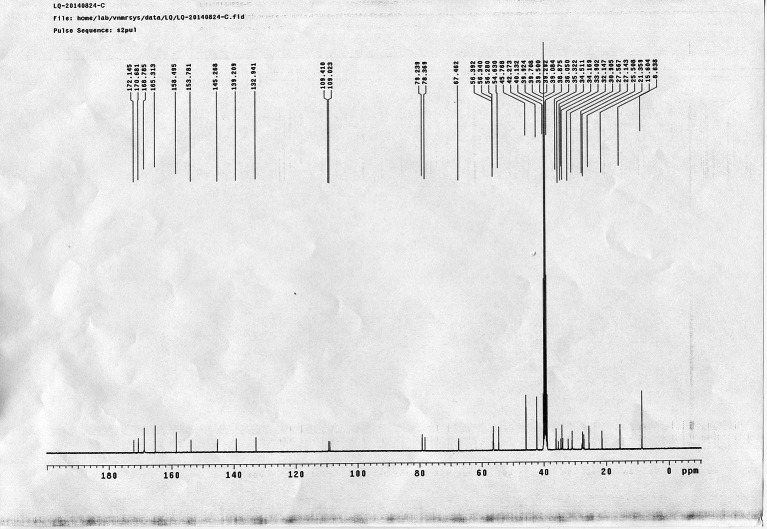
13C NMR spectra of sulfo-PL.